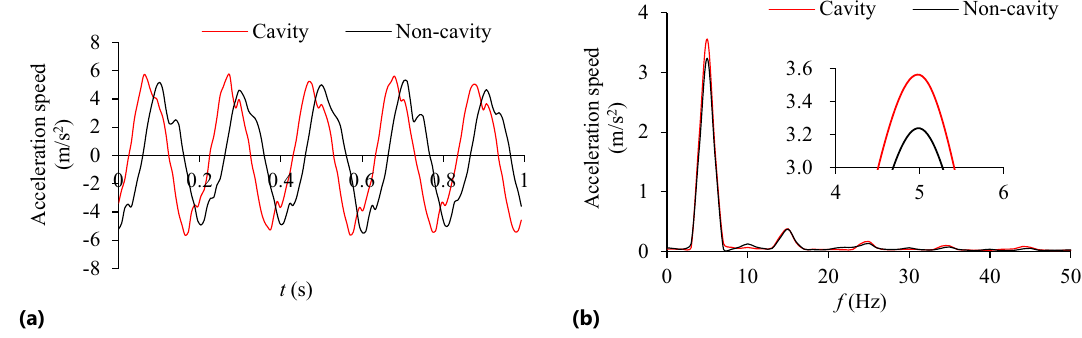
Figure 17. Acceleration speed of system n = 90 r/min: (a) Time-domain; (b) Frequency domain.